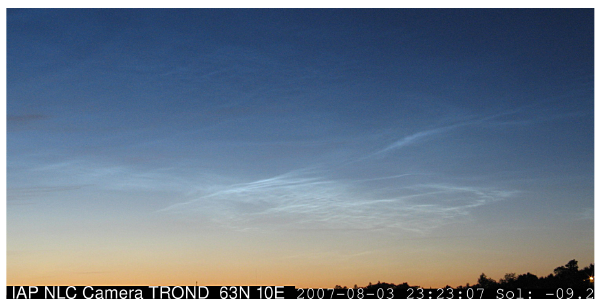
Fig. 13. Close up of the noctilucent cloud observed from Trondheim on 3 August 2007 23:23UT during the ECOMA flight. The time is given in the